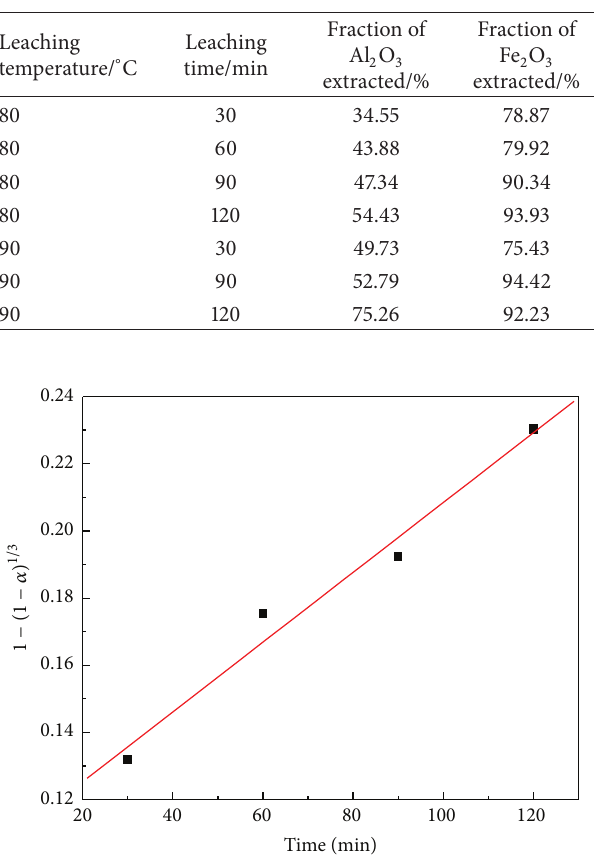
Figure 2: Leaching kinetics fitting curve of aluminum